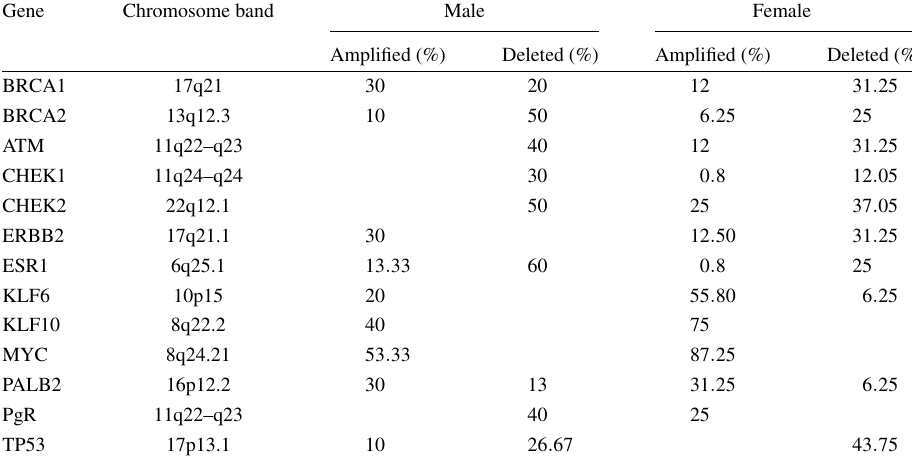
Hereditary breast cancer genes alterations